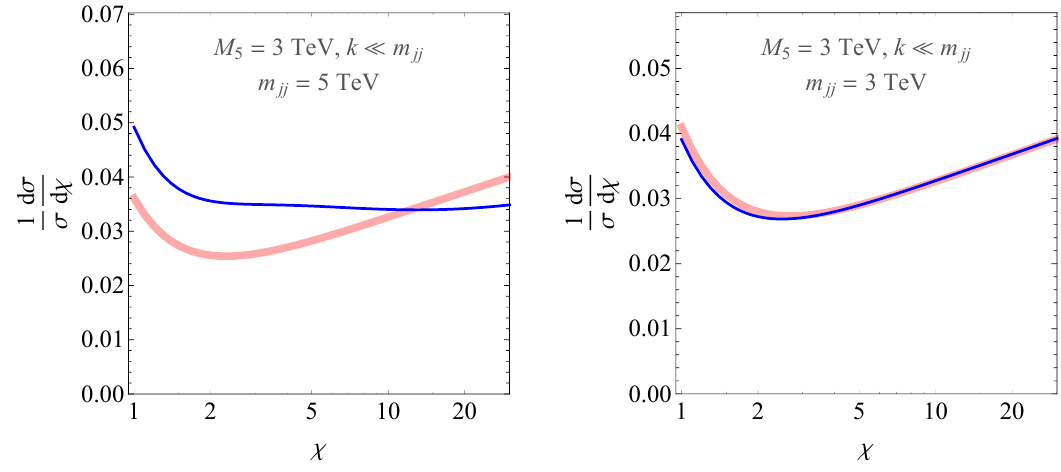
Figure 11 . Dijet angular distributions of the background (thick pink) and background+signal (thin blue), for M 5 = 3 TeV, in the limit of k (cid:28) m jj . The variable (cid:31) , used in refs. [74{76], is de(cid:12)ned in terms of the rapidities of the two jets as (cid:31) (cid:17) exp( j y 1 (cid:0) y 2 j ). As discussed in the text, while formally events with m jj = 5 TeV (left plot) can be used to constrain the scenario, the interpretation is uncertain because m jj & M 5 is beyond the validity range of the theory. On the other hand, even events with m jj = 3 TeV (right plot) already do not have much discriminating